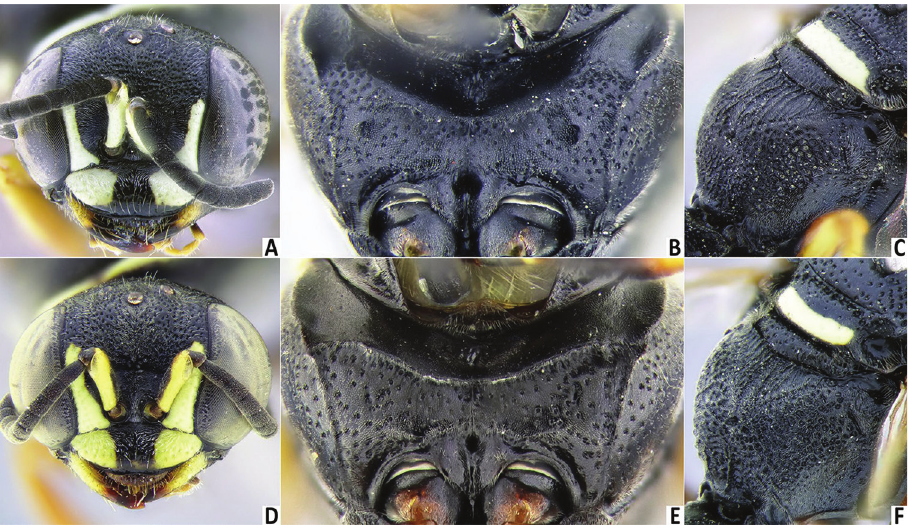
Figure 8. Hoplisoides craverii (A. Costa), female ( A–C ), and H. punctuosus (Eversmann), female, from Dagestan, Russia [MMPC] ( D–F ): A, D head, frontal view B, E metasoma, ventral view C, F scutellum, metanotum and propodeum, posterolateral